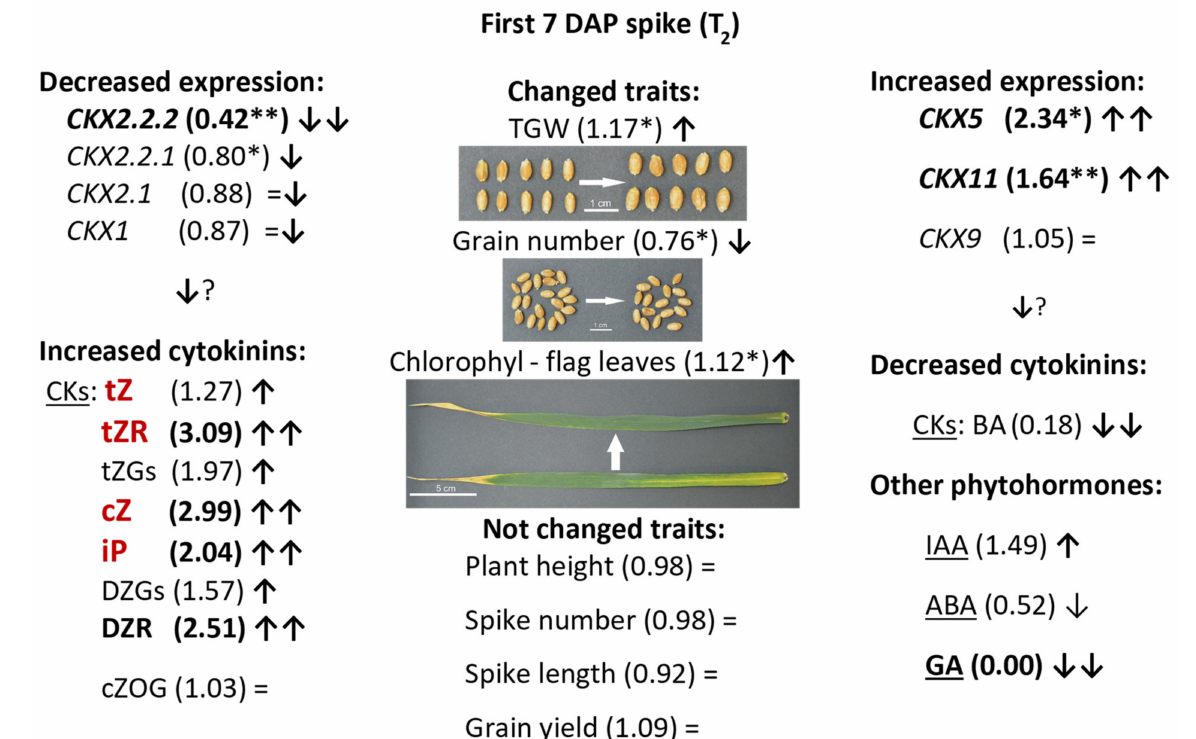
Figure 5. Schematic presentation of up ( ↑ ) or down ( ↓ ) regulation of expression of TaCKX GFMs, phytohormone content and yield-related traits in 7 DAP spikes of silenced, T 2 lines. Relative to the control = 1.00 values are in brackets. Highly decreased ( ↓↓ ) or highly increased ( ↑↑ ) values are in bold. *—significant at p ≤ 0.05; **—significant at p ≤ 0.01. CKs in red are substrates for CKX enzyme. =—not changed; ?—expected